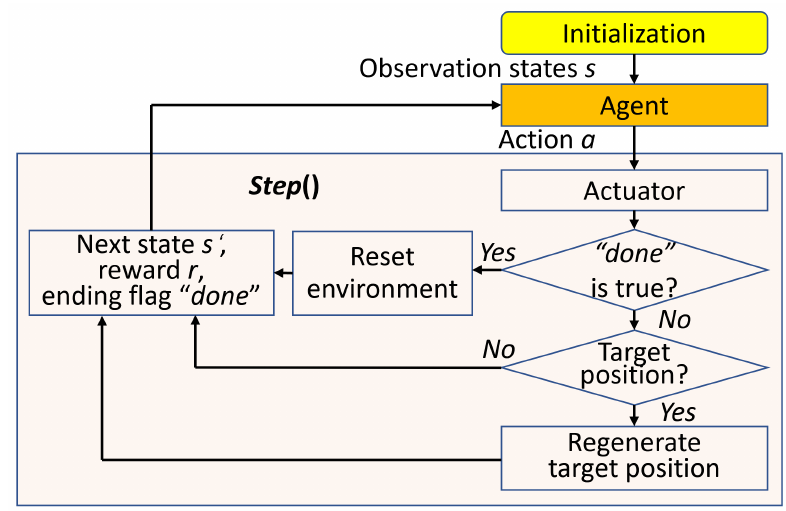
Figure 7. The flowchart of partial DRL environment.